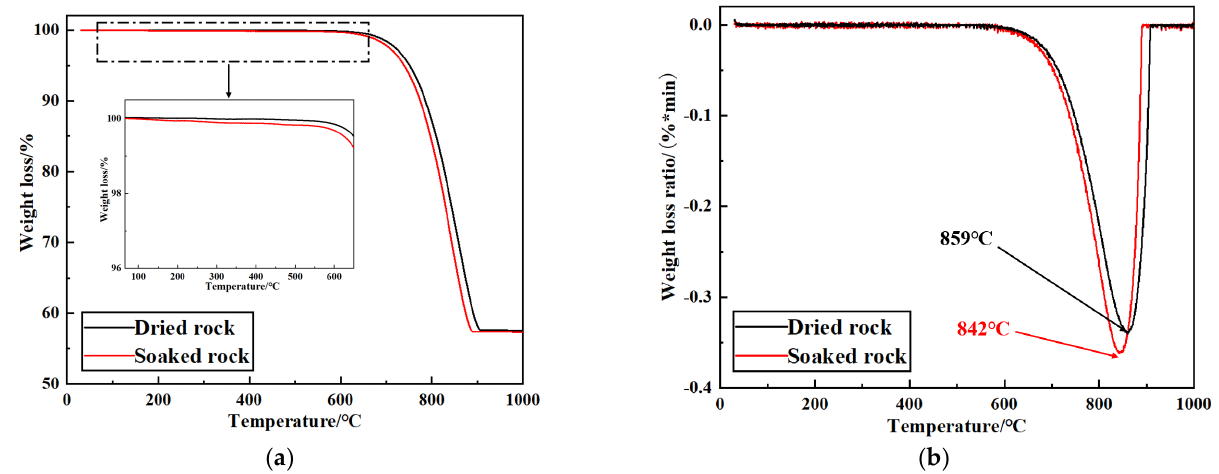
Figure 14. Plots of: ( a ) thermogravimetric curve; and ( b ) weight-loss rate with temperature.